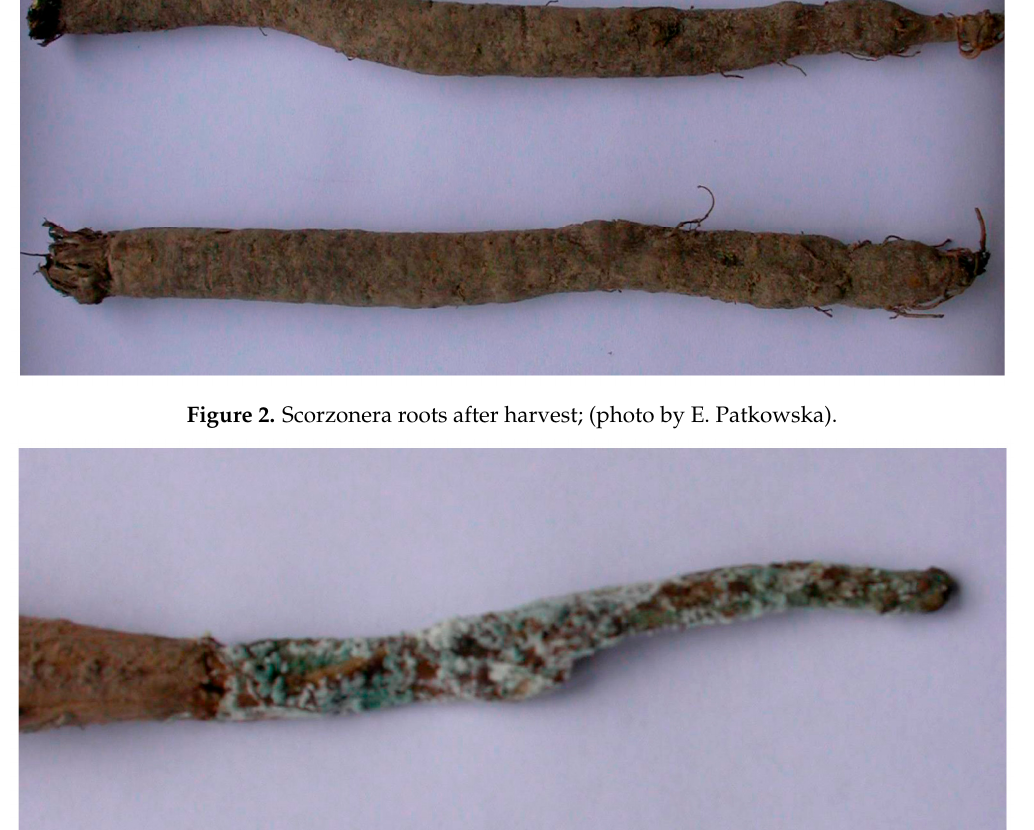
Figure 3. Mycelium and conidia of Penicillium sp. on the scorzonera root (scale 3:1); (photo by E. Patkowska).